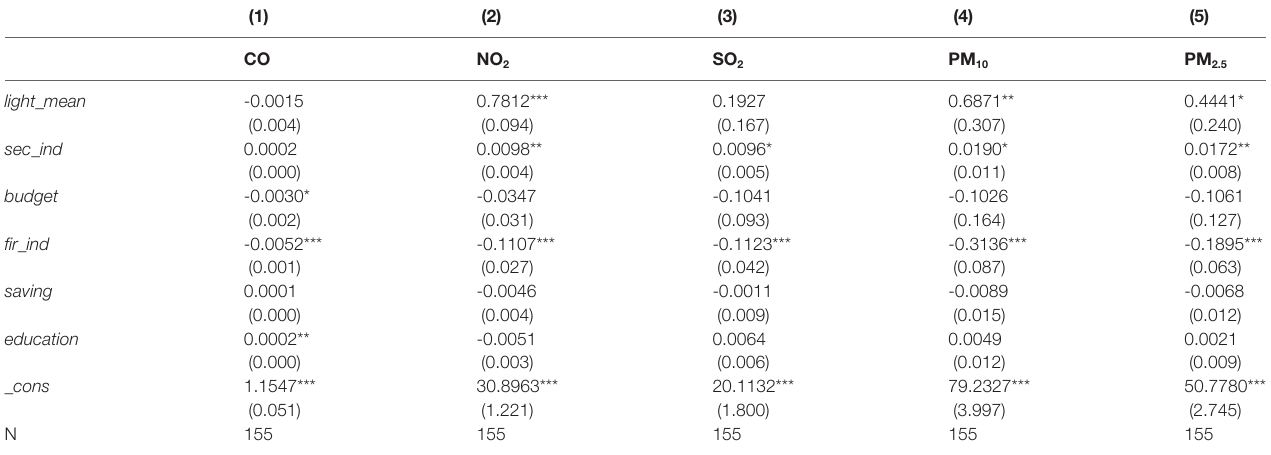
TABLE 4 | The impact of economic development on air pollutants with control variables. (1)